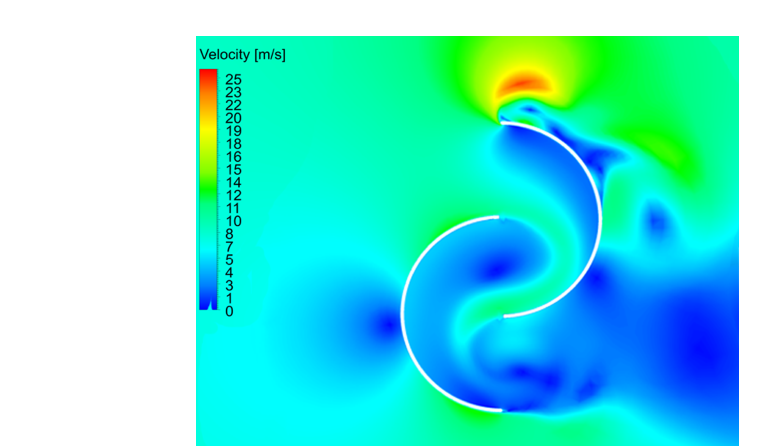
Figure 9: Velocity distribution in stn. frame for different Savonius wind turbines